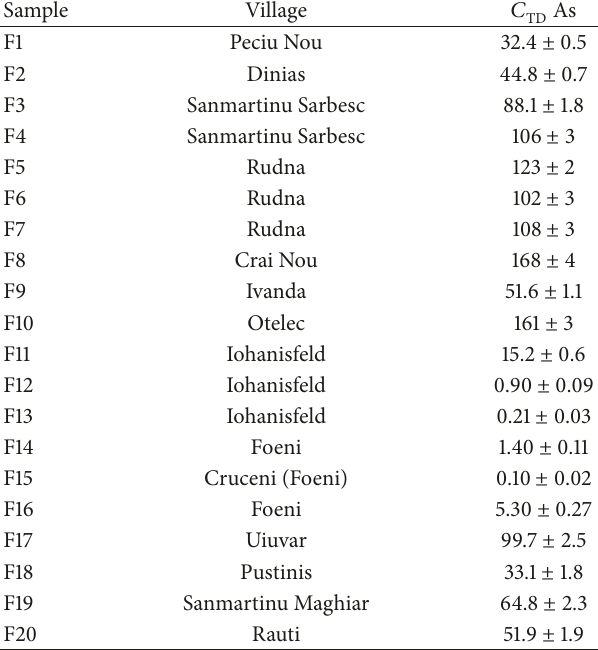
Table 1: Concentration of total-dissolved As in water samples ( 𝜇 gL −1 , average ± SD, 𝑛 = 3 parallel